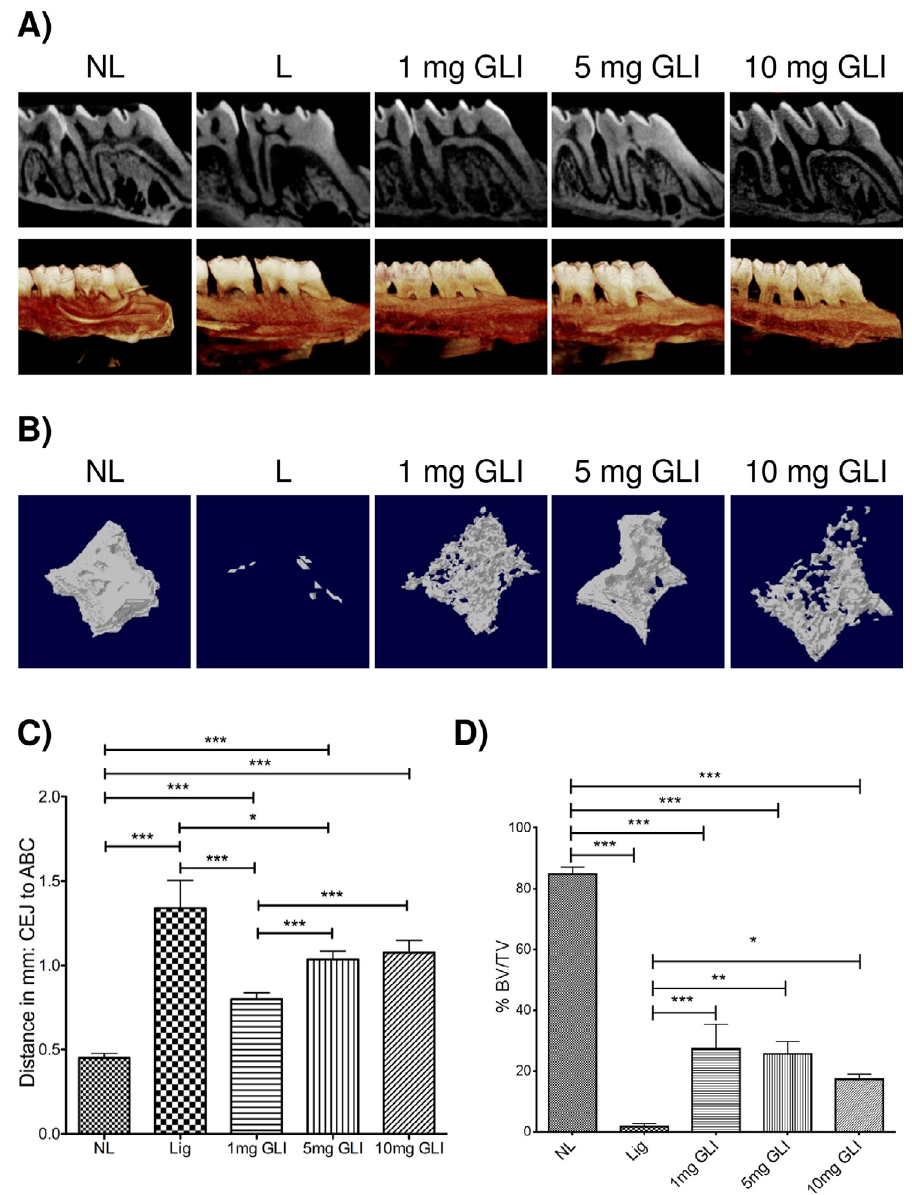
Figure 2- Radiographic evaluation after gliclazide (GLI) treatment and induction of experimental periodontitis. (A) Representative sagittal 2D and 3D micro-CT images from the no ligature (NL), ligature (L), and GLI 1, 5, and 10 mg/kg groups. (B) Representative sagittal 2D and 3D micro-CT images from the NL, L, and GLI 1, 5, and 10 mg/kg groups. (C) Graph representing linear bone loss in the area of the mesial second molar. Distance (in millimeters) from the cementoenamel junction to the alveolar bone crest. Data are mean±standard area of the mean. *p<0.05, *p<0.01, ***p<0.001 (n≥3 for all groups/time points). (D) Graph representing the bone volume/total volume percentage in the area below the second molar bifurcation. Data are mean±standard area of the mean. *p<0.05, *p<0.01, ***p<0.001 (n≥3 for all